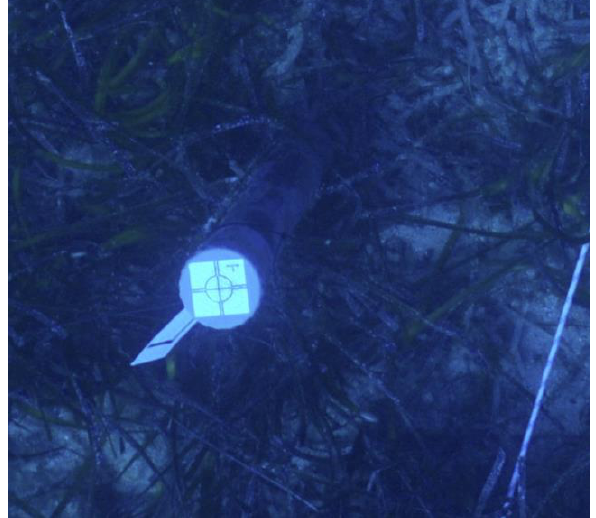
Figure 2. Control point fixation and